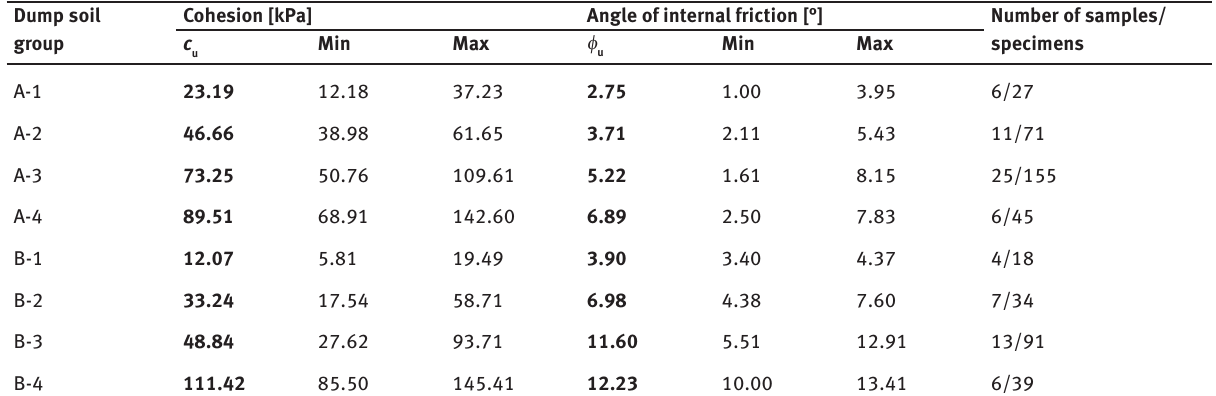
Table 4: Result of strength tests. Dump soil